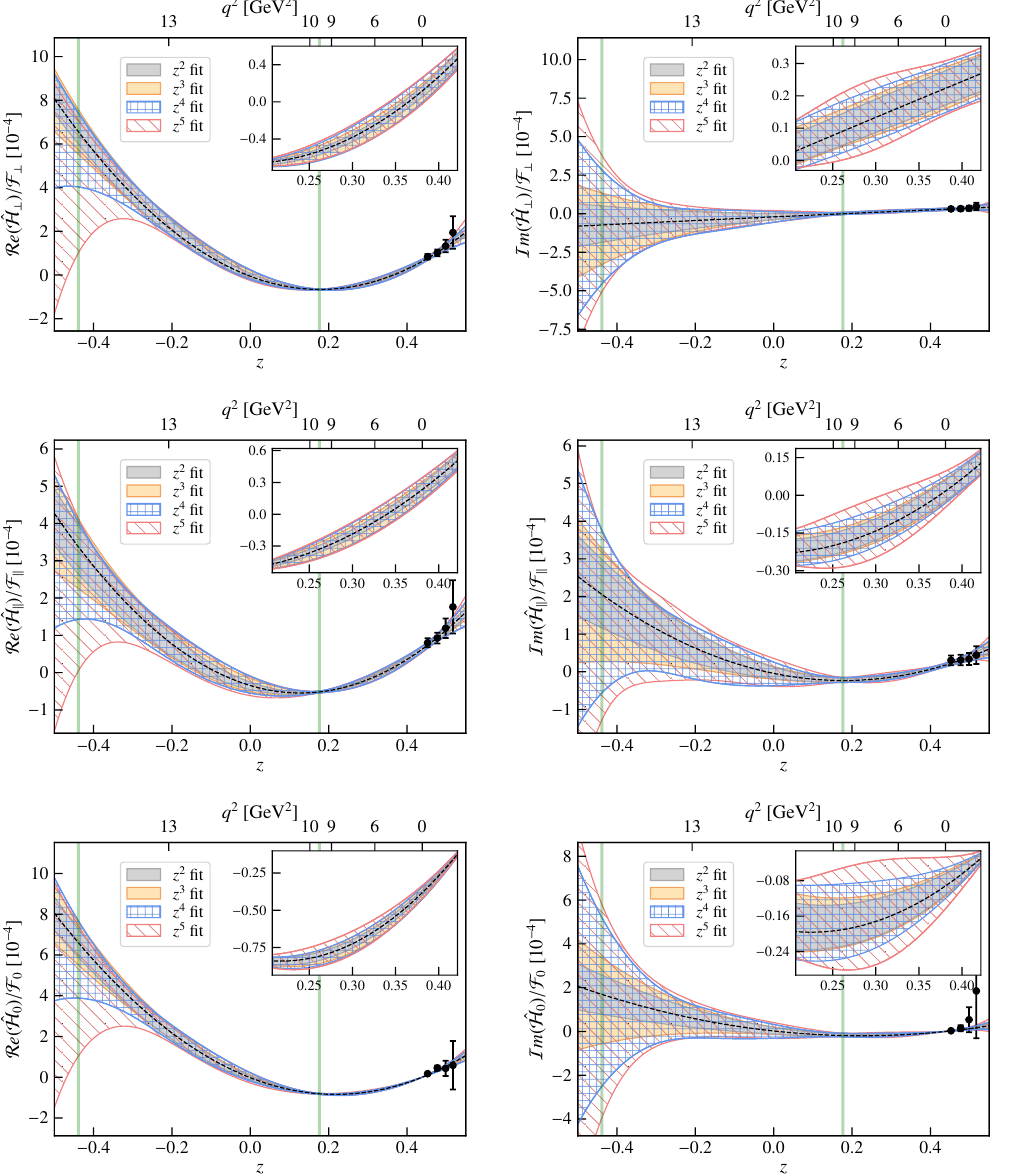
Figure 1 . Results of the (cid:12)ts for the ratio Re ^ H (cid:21) ( z ) = F (cid:21) ( z ) obtained with di(cid:11)erent orders of the expansion for the BMP scenario and the expected statistics at LHCb Upgrade [50 fb (cid:0) 1 ]. The vertical bands correspond to the J= and (2 S ) regions; the points to the theoretical inputs at negative q 2 . The top right box of each plot zooms in the q 2 range between 1.1 and 9.0 GeV 2